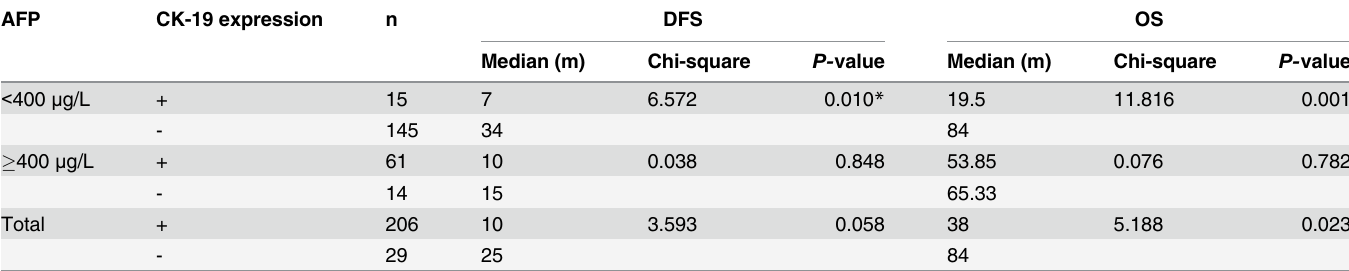
Table 5. Analysis of serum AFP concentration, CK-19 expression, and prognosis in patients with HCC who underwent radical resection.